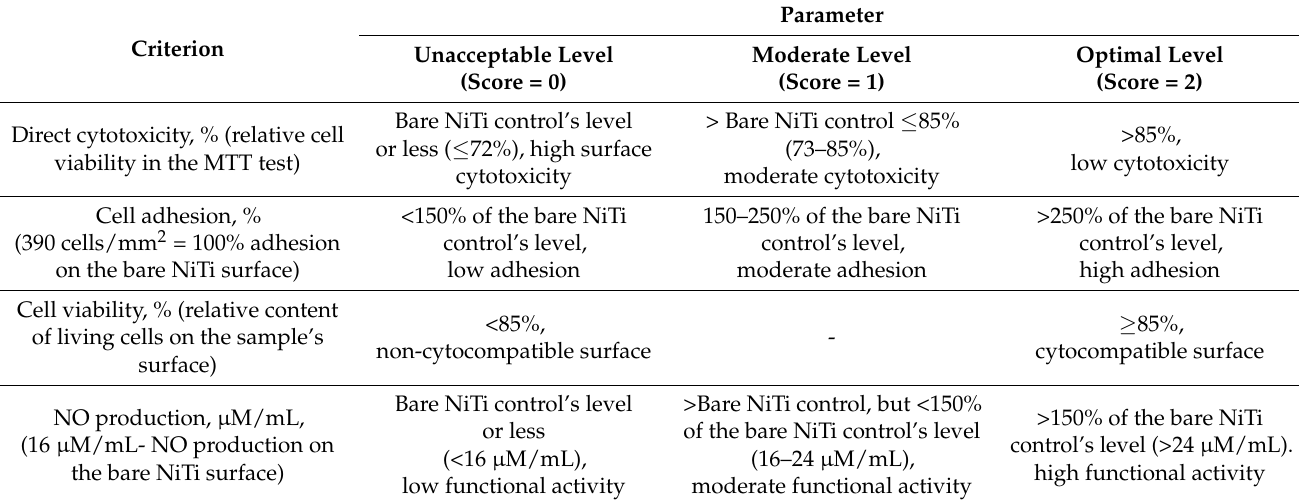
Table 3. Ranking the assessment of the biological test